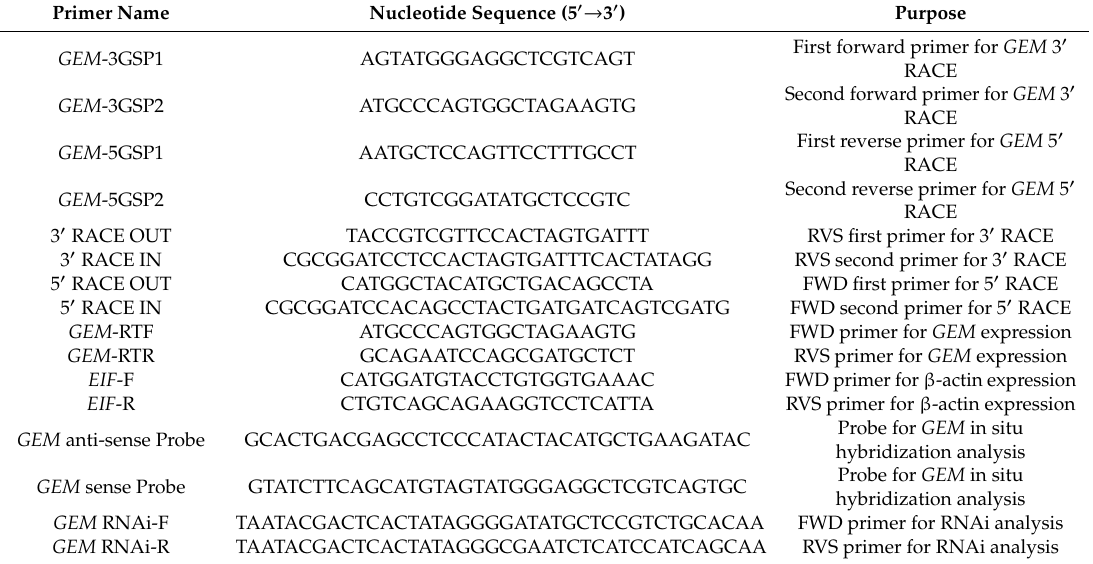
Table 2. Universal and specific primers used in this